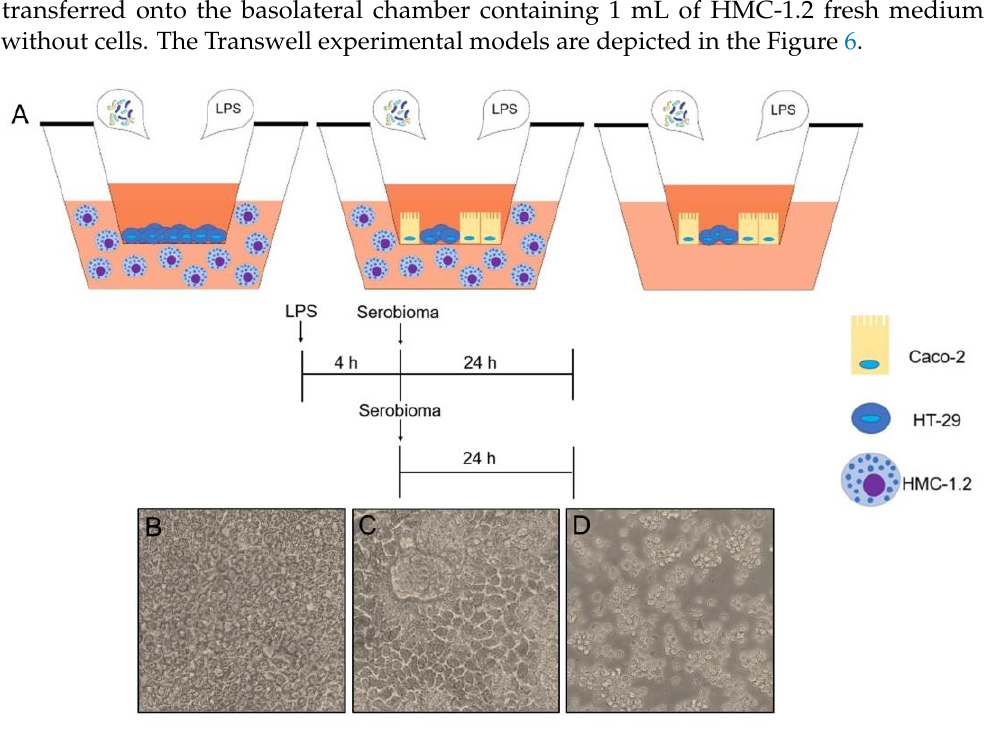
Figure 6. Schematic representation of the Transwell co-culture models ( A ). Microphotograph of 7-day confluent HT-29 ( B ), 18-day Caco-2/HT-29 co-culture ( C ), and HMC-1.2 ( D ), 20× magnification.